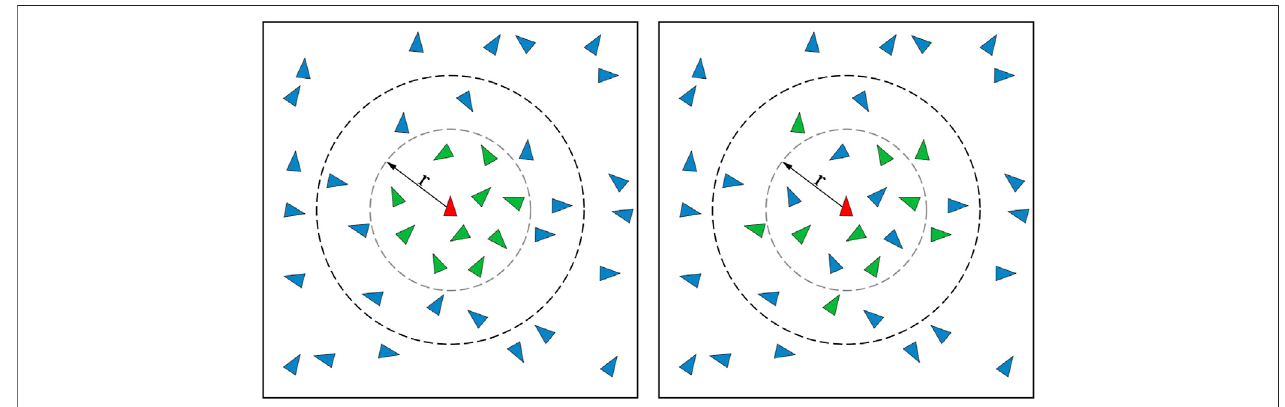
FIGURE4| (Left)Astandardcommunicationmodelwithanagentincommunicationwithits10nearestneighbors.(Right)Aforcedswitchingcommunicationmodel where k s (cid:2) 5 of the nearest neighbors are substituted with a more distant set of neighbors within the black circle with a probability of p . (Kuan,